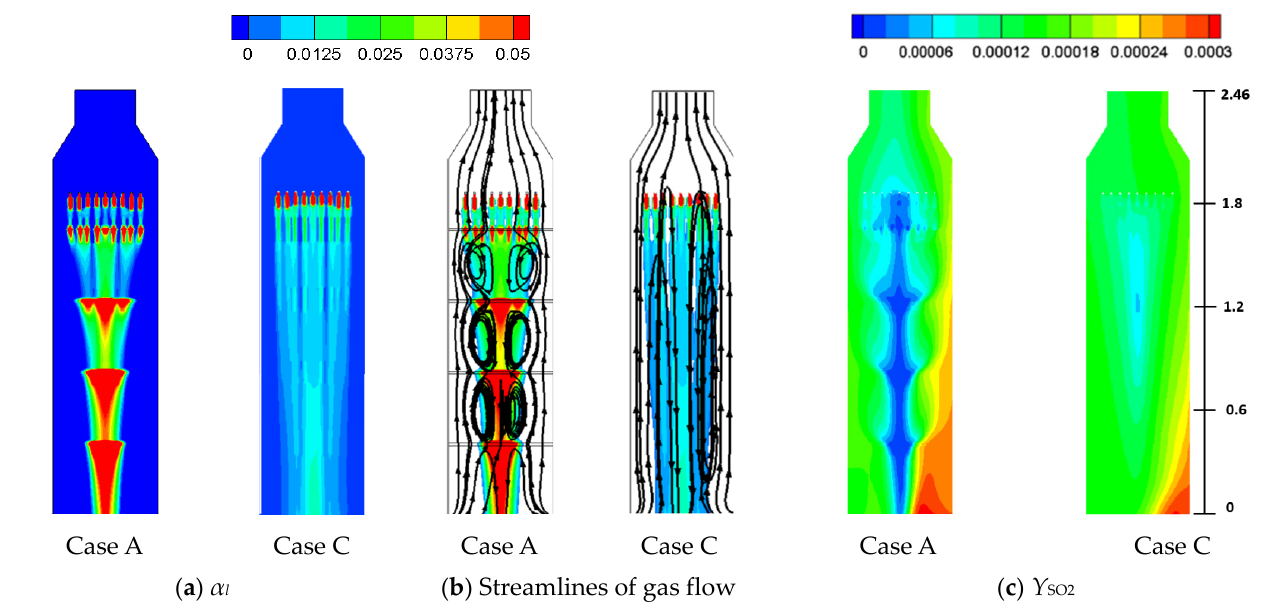
Figure 12. The figure displays ( a ) the liquid volume fraction, ( b ) streamlines of gas flow, and ( c ) the mass fraction of SO 2 within the right tower of a small-scale FGD facility for Case A and Case C (empty tower).